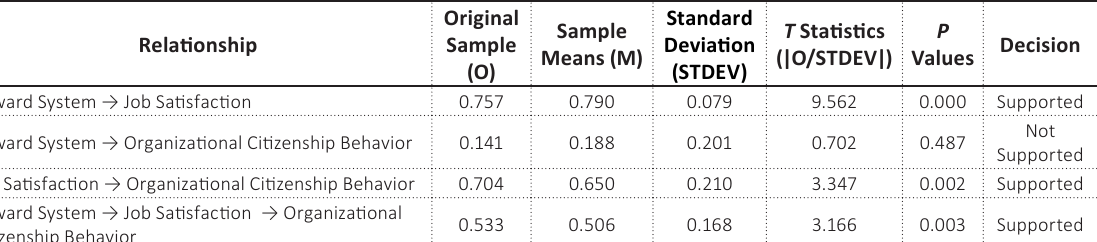
Table 5. Hypotheses testing results